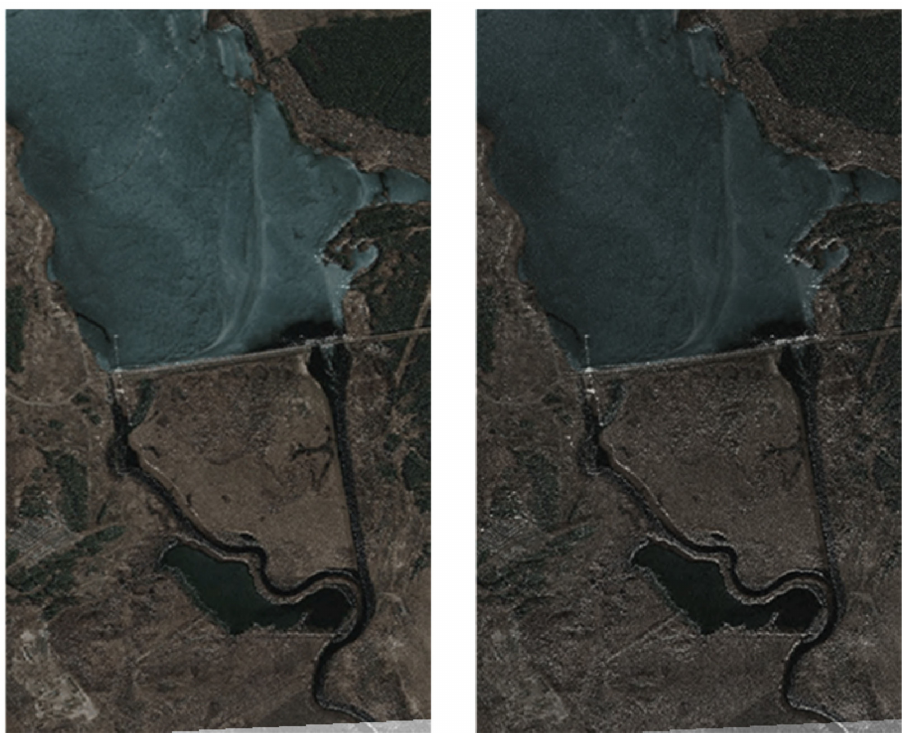
Figure 12. Fused image.